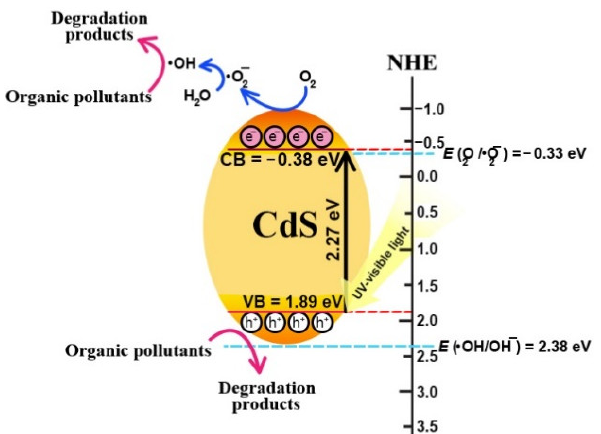
Figure 7. Lowering of the RR141 concentration in the presence of CdS nanoparticles under visible light irradiation ( a ) and rate constant (k) of photodegradation ( b ) in the presence of various scavengers.